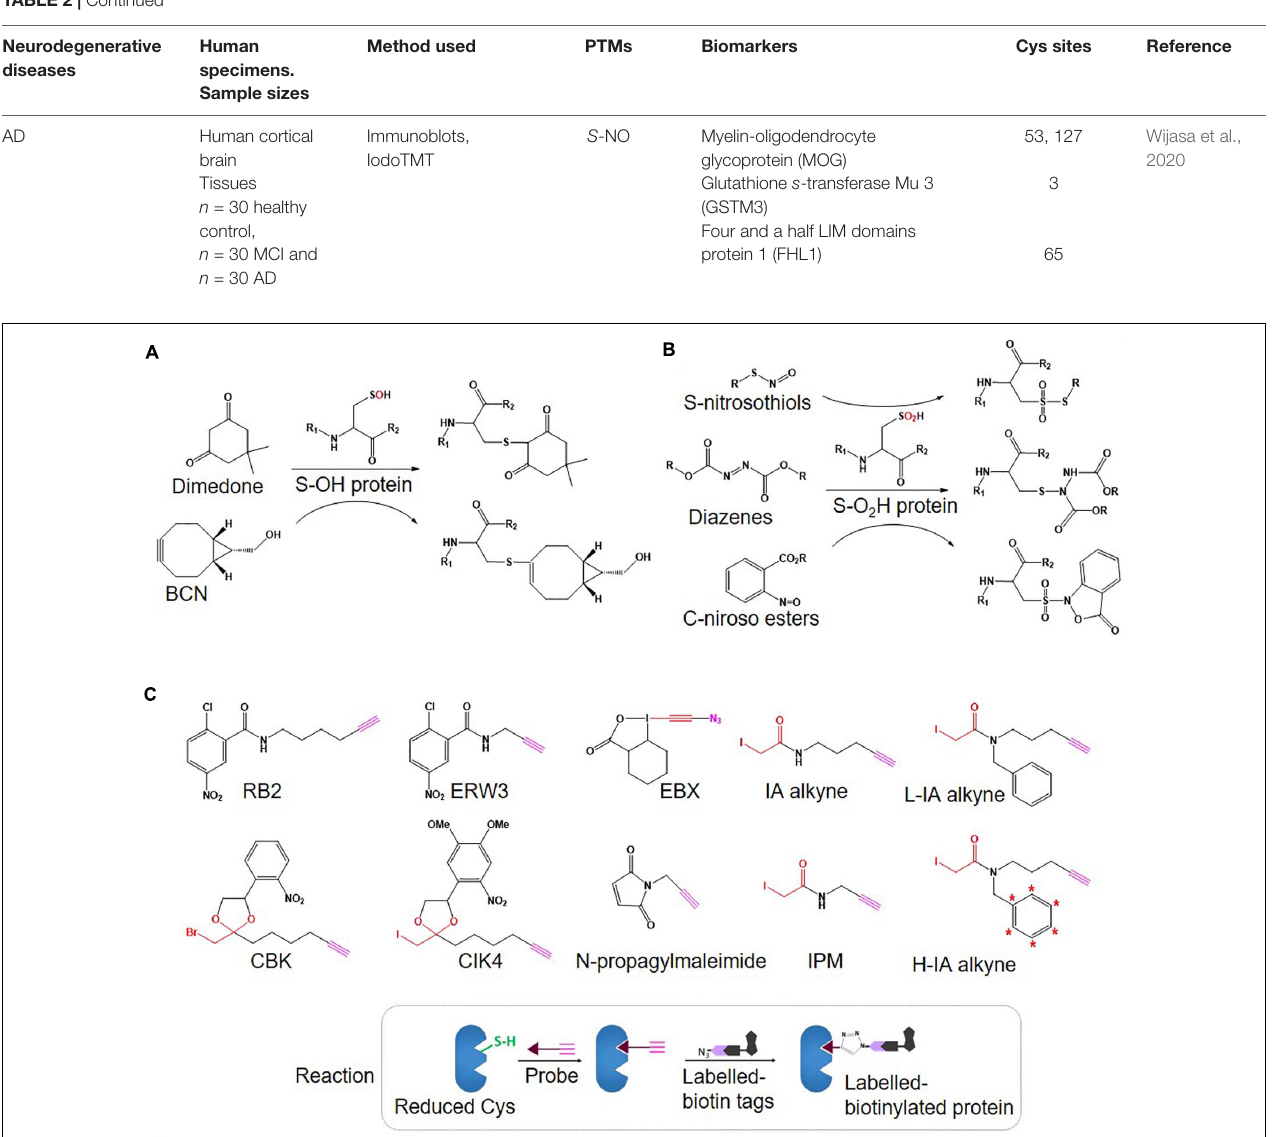
FIGURE 5 | Structure of probes used for selective Oxi-Cys ( A: S -OH and B: S -O 2 H) and click chemistry-based (C) approaches.